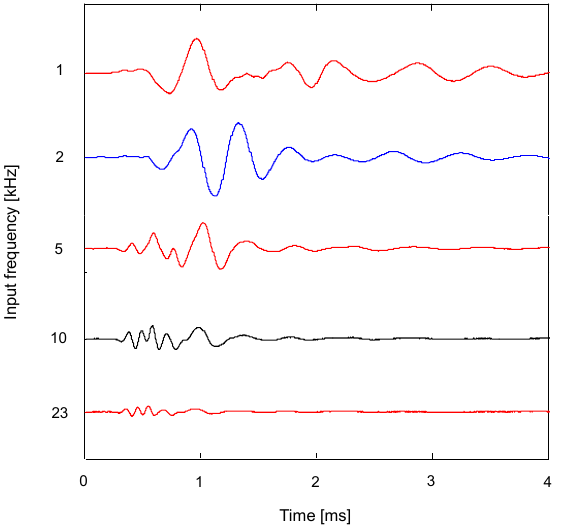
Figure 7. Variation in waveform obtained from ring bender along with the frequency of input sig- nal.